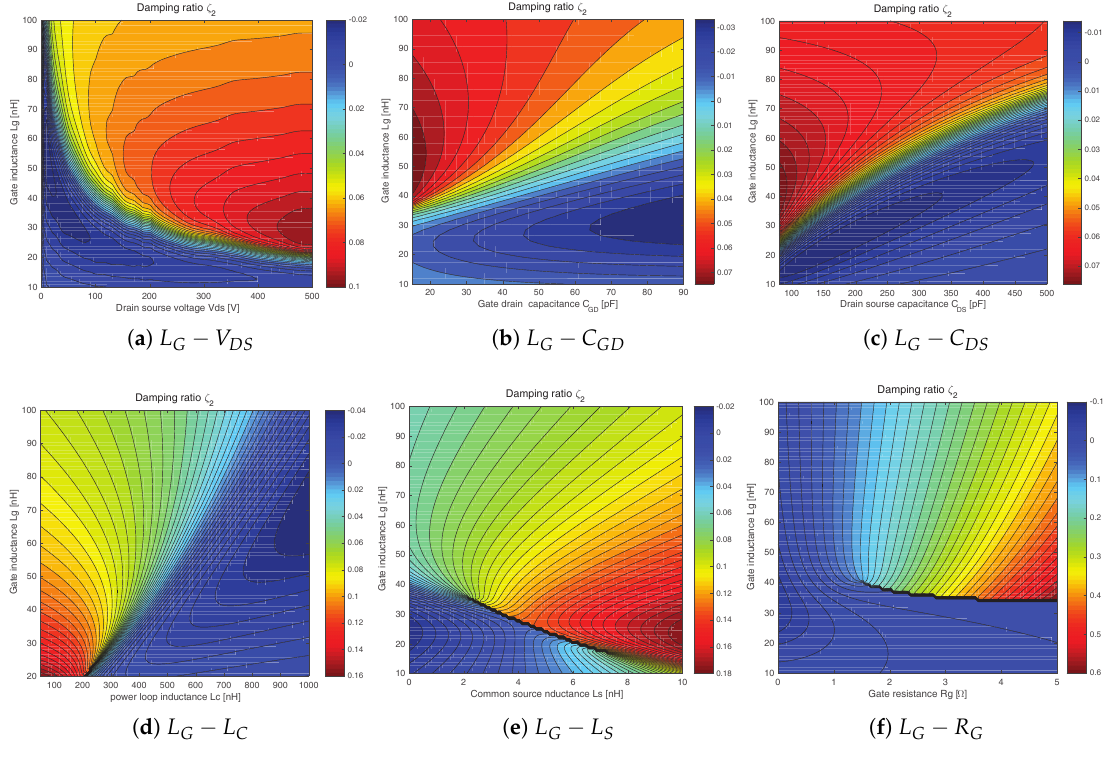
Figure 14. The calculated damping ratio ζ 2